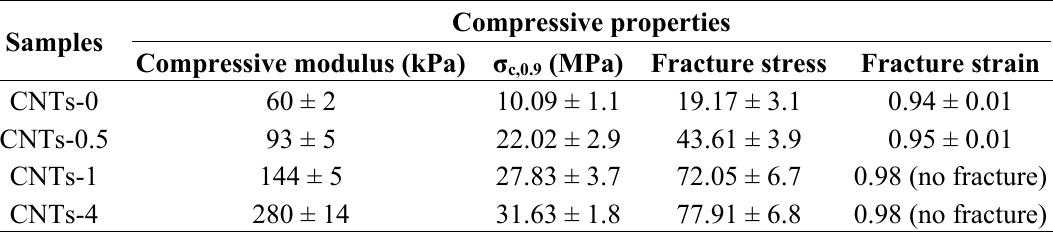
Table 1. The compressive properties of nanocomposite double-network (DN) hydrogels. Samples